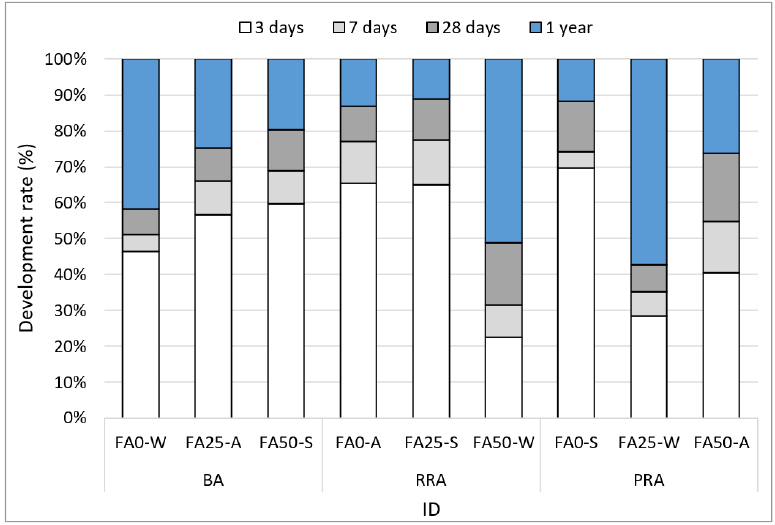
Figure 8. Development rate on compressive strength of concrete.